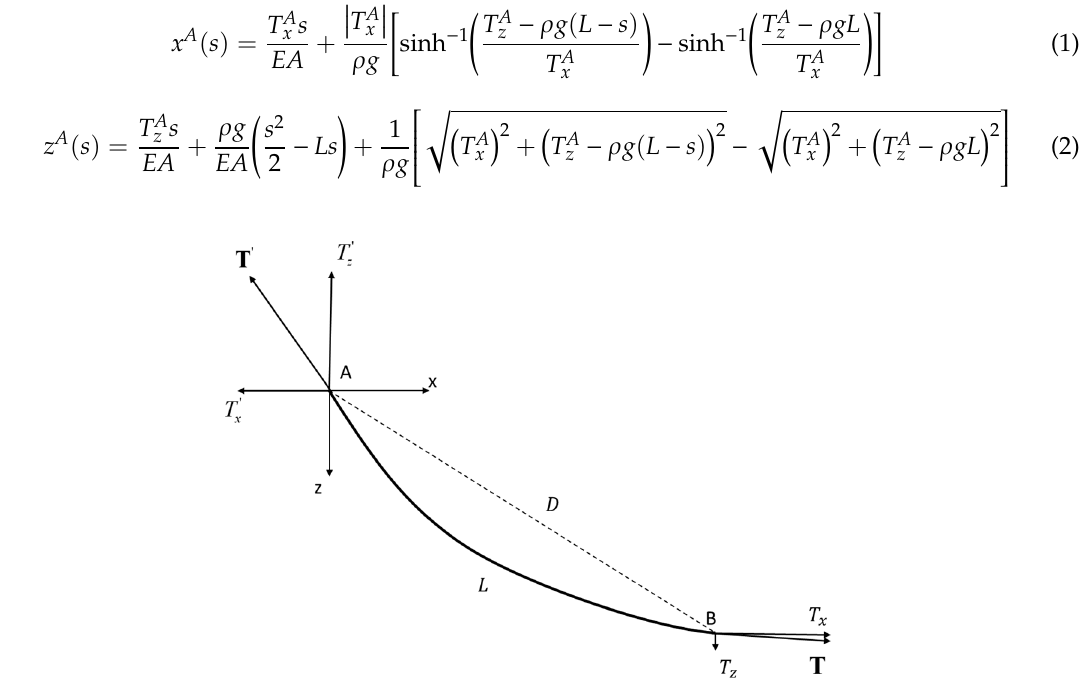
{ } A . Figure 1. Cable sag model in frame { A }